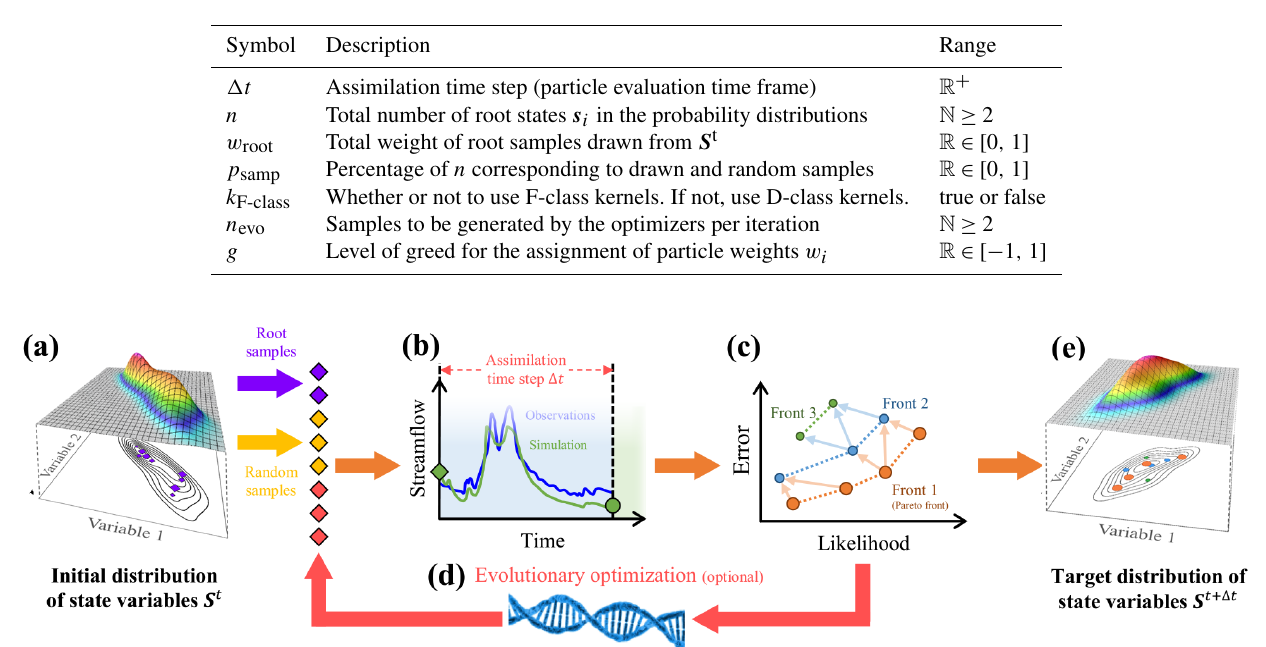
Figure 1. Steps in OPTIMISTS, to be repeated for each assimilation time step (cid:49)t . In this example state vectors have two variables, obser- vations are of streamflow, and particles are judged using two user-selected objectives: the likelihood given S t to be maximized and the error given the observations to be minimized. (a) Initial state kernel density distribution S t from which root samples (purple rhombi) are taken during the drawing step and random samples (yellow rhombi) are taken during the sampling step. (b) Execution of the model (simulation step) for each source sample for a time equal to (cid:49)t to compute output variables (for comparison with observations) and target samples (circles). (c) Evaluation of each particle (evaluation step) based on the objectives and organization into non-domination fronts (ranking step). The dashed lines represent the fronts while the arrows denote domination relationships between particles in adjacent fronts. (d) Optional optimization step which can be executed several times and that uses a population-based evolutionary optimization algorithm to generate additional samples (red rhombi). (e) Target state kernel density distribution S t + t constructed from the particles’ final samples (circles) after being weighted according to the rank of their front (weighting step): kernels centred on samples with higher weight (shown larger) have a higher probability density